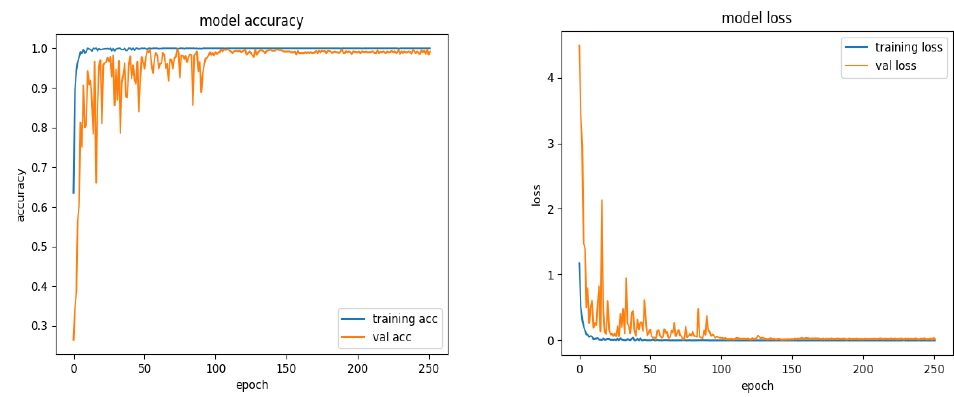
Figure 7. Visualization graphs for training and validation.